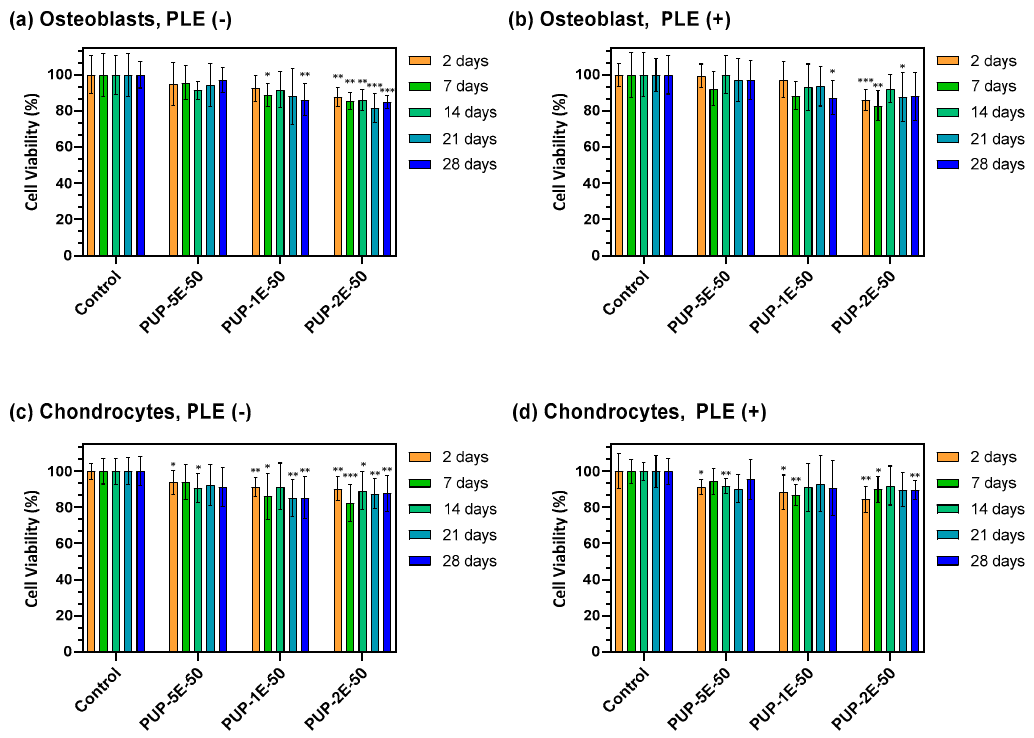
Figure 7. Cytotoxicity analysis of PABA-based polyurethanes on ( a ) HOb cells in absence of PLE, ( b ) HOb cells in presence of PLE, ( c ) HC-a cells in absence of PLE and ( d ) HC-a cells in presence of PLE. Data show the mean value and standard deviation (n = 12). Statistical differences between polyurethanes and control were analyzed by analysis of variances (ANOVA) and Tukey’s Test, considering statistically significant difference when p ≤ 0.05 (*), p ≤ 0.01 (**) and p ≤ 0.001 (***).